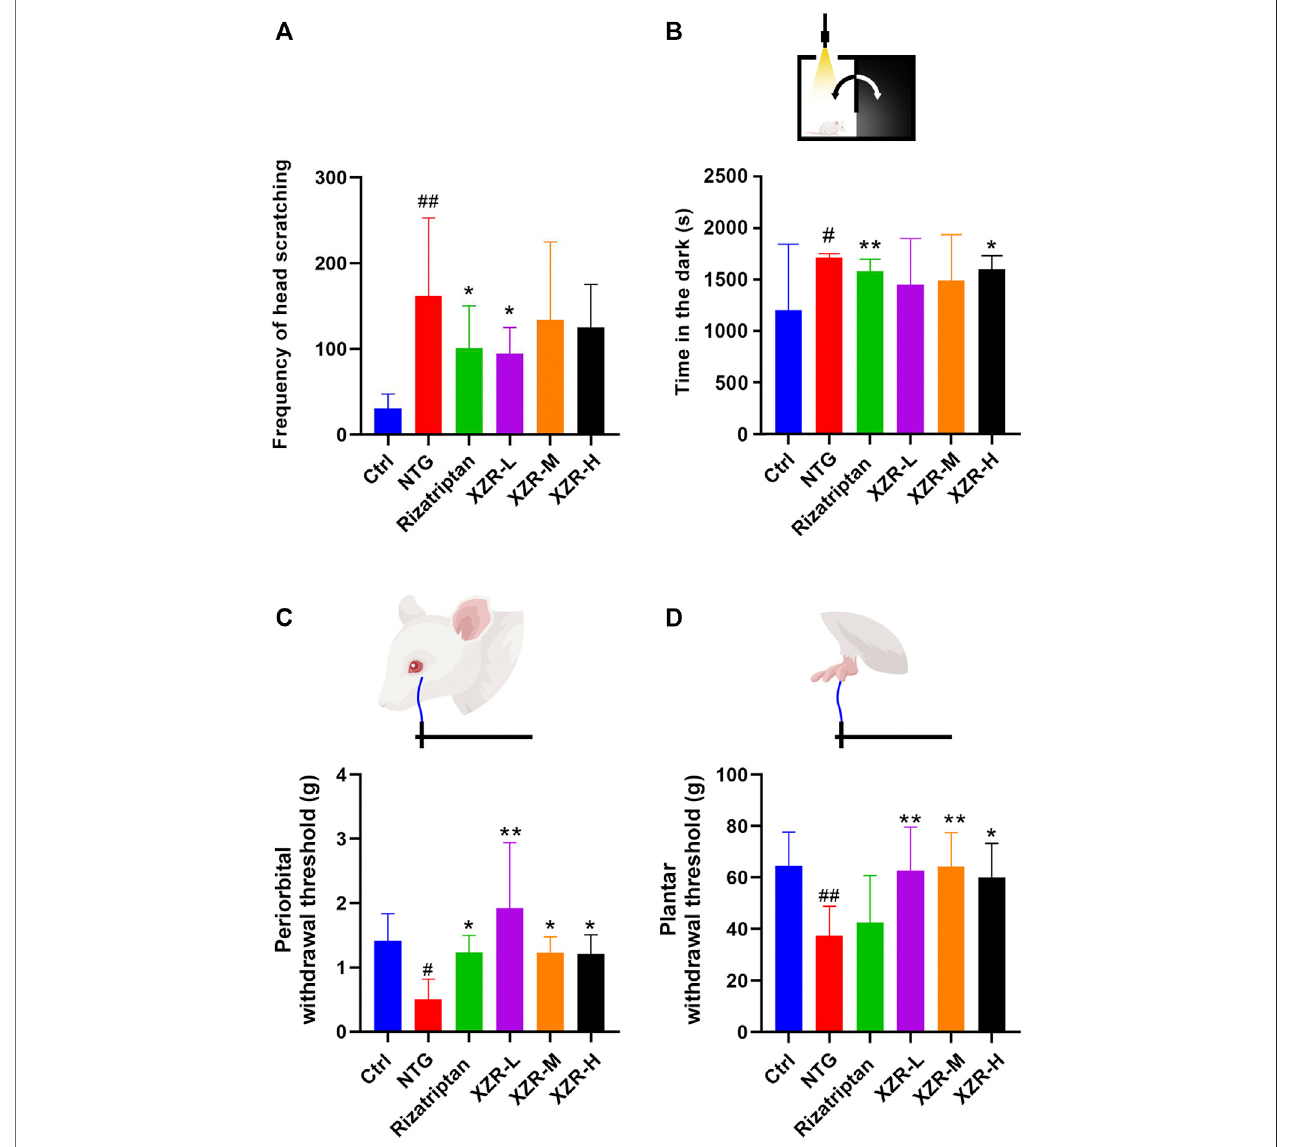
FIGURE 2 | XZR improved migraine-like behavior in the NTG-induced migraine rat model. (A) Frequency of head scratching. (B) Time in the dark chamber. (C) Periorbitalwithdrawalthreshold. (D) Plantarwithdrawalthreshold.Dataarepresentedasthemean±standarddeviation. # p < 0.05, ## p < 0.01versuscontrolgroup,* p < 0.05, ** p < 0.01 versus NTG group, n = 7 – 10. XZR, Xiongshao Zhitong Recipe; NTG,